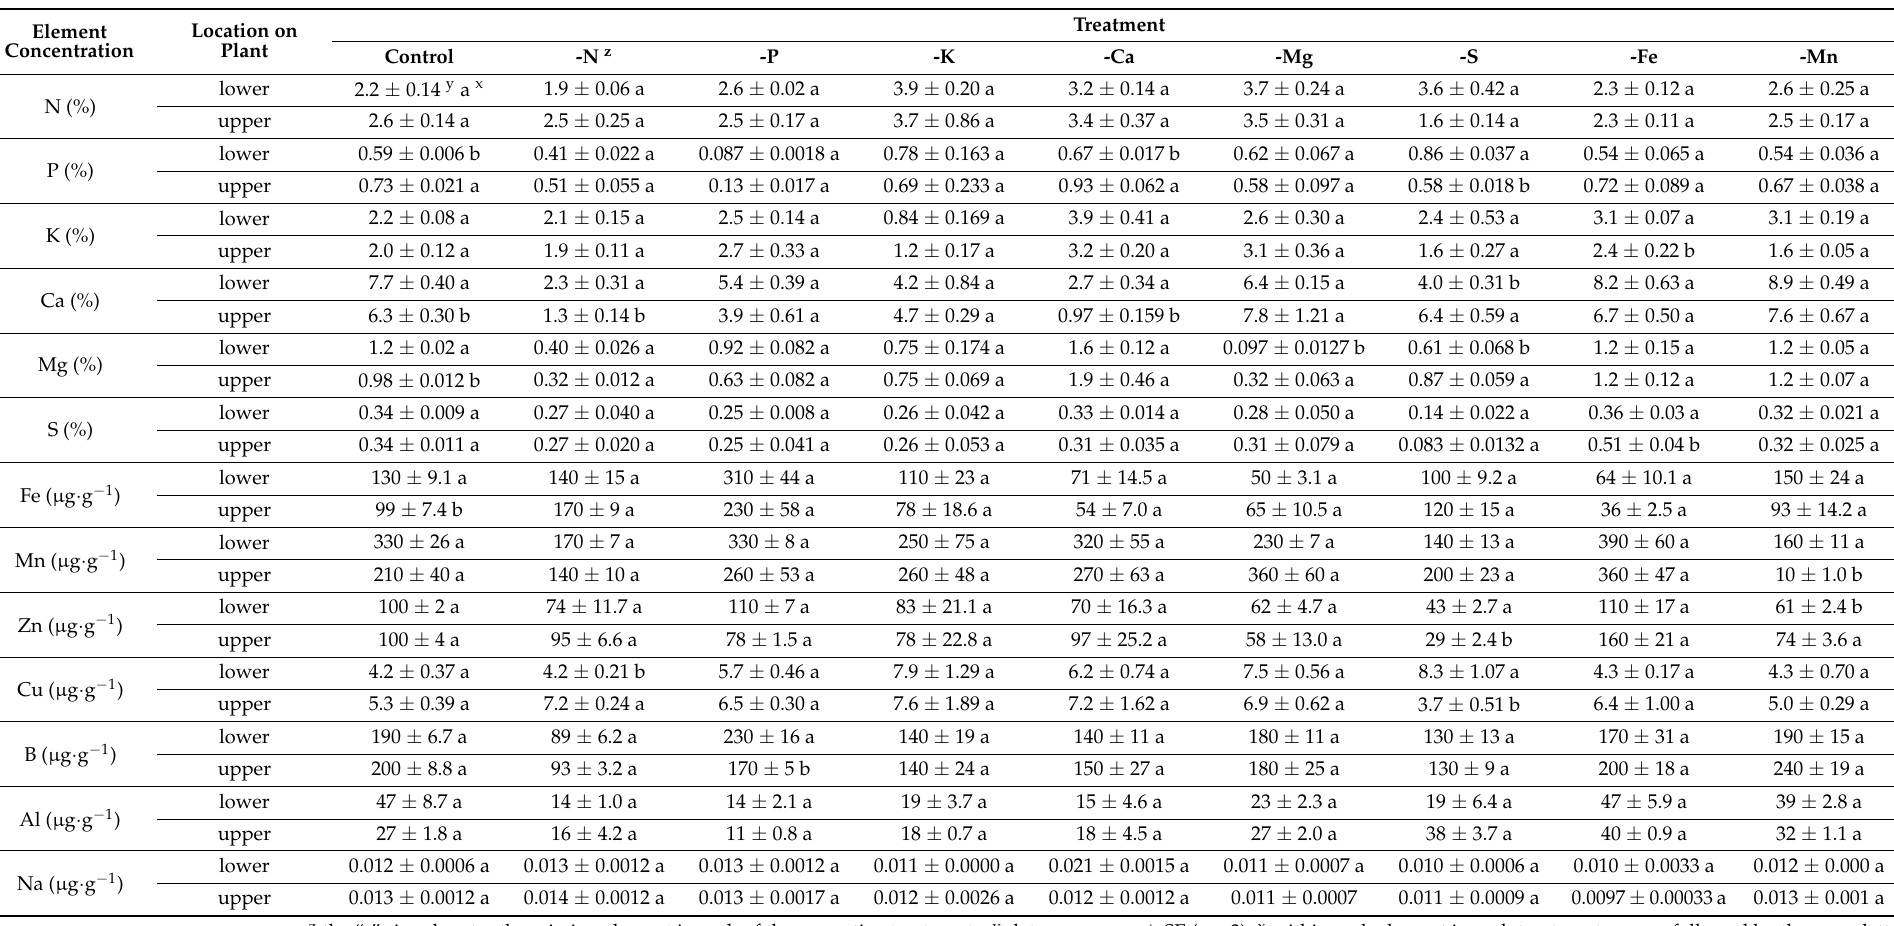
Table 4. Elemental concentrations (% of DW or µ g · g − 1 ) in foliar tissues from the upper and lower canopy of each of the nutrient treatments, sampled during the week that deficiency symptoms in each respective plant